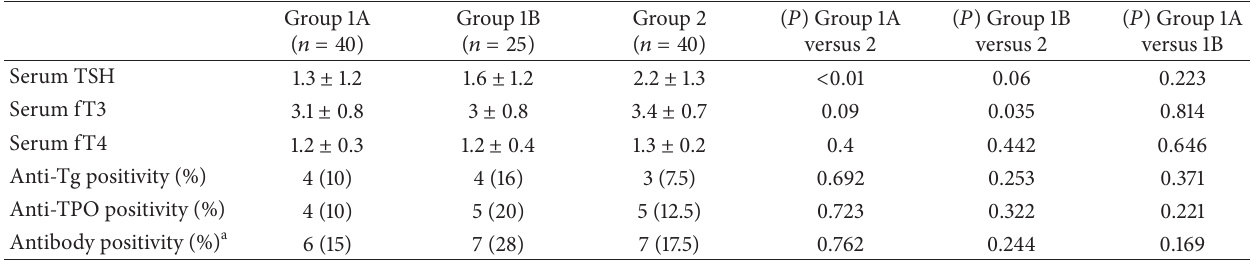
Table 1: Thyroid function tests and autoantibody panel of the patients with Cushing’s syndrome and control subjects. Group 1A corresponds to the patients before cure whereas Group 1B includes the patients after cure for Cushing’s syndrome. Group 2 is the control group.